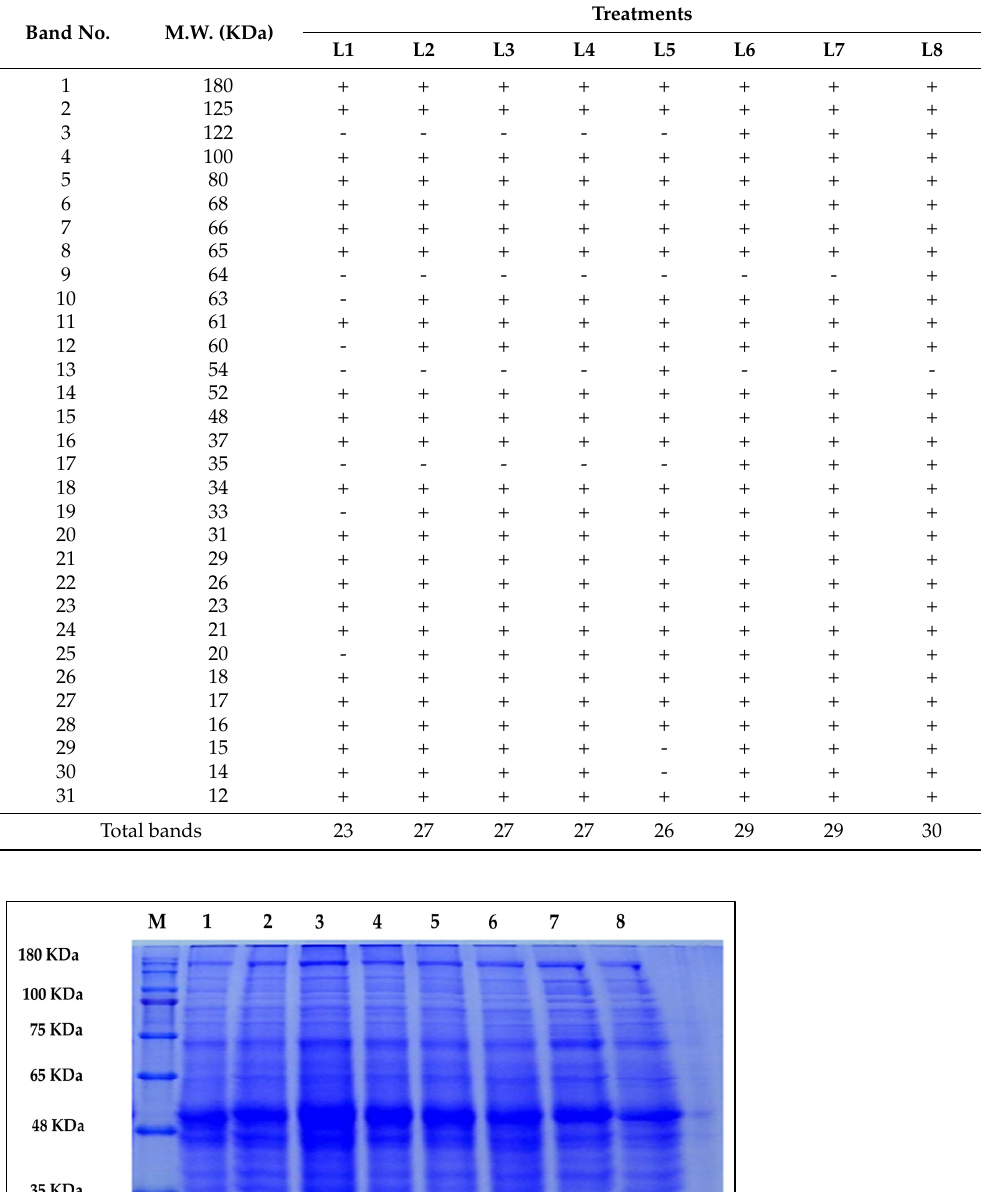
Table 3. Analysis of molecular weights (M.W.) of protein profile in flag leaves of wheat plants grown under drought stress and pre-treated with arginine. L1: normal control, L2: arginine 0.25 mM,